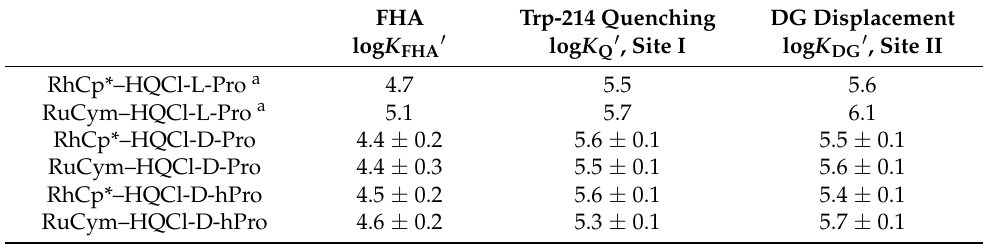
Table 4. Conditional formation constant (log K FHA (cid:48) ) for the formation of the ternary complex with FHA determined by 1 H NMR spectroscopy { c FHA = 0.5 or 1 mM, c complex = 0.5 or 1 mM, pH = 7.4, (PBS’); 10% ( v / v ) D 2 O}, Trp-quenching (log K Q (cid:48) ) and DG marker displacement (log K DG (cid:48) ) constants of the complexes for their binding to HSA at site I and II, respectively, obtained from spectrofluorometric measurements. { c HSA = 1 µ M, c DG = 1 µ M, c complex = 0–40 µ M, λ EX = 295 nm (Trp-214) or λ EX = 335 nm